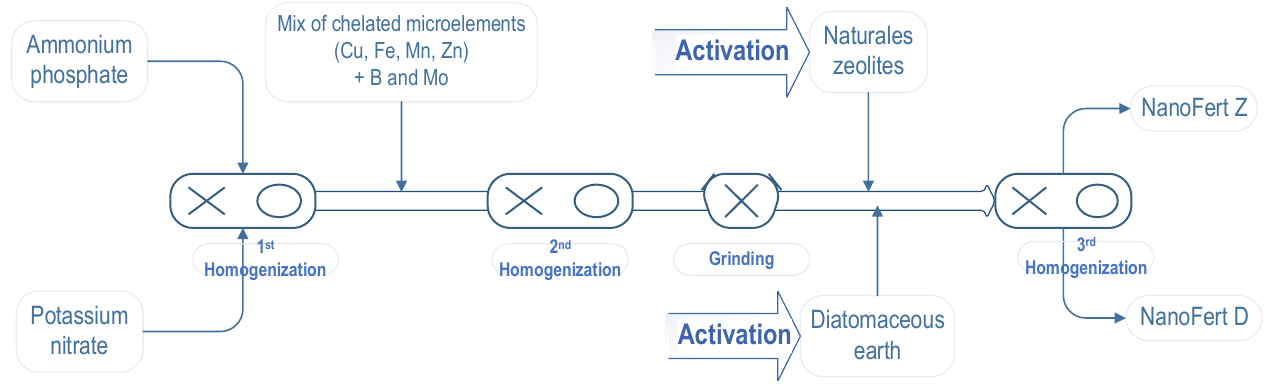
Figure 1. Presentation of the preparation process of two-in-one products, particle film-forming and foliar fertilizer, NanoFert Z (with natural zeolites) and NanoFert D (with diatomaceous earth) foliar fertilizers. Modified from Moale et al. [34]. Copyright 2021, by the authors.